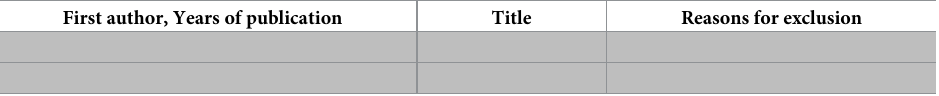
Table 3. Exclusion table from systematic review and meta-analysis of randomized controlled trials to evaluate the effects of PFM exercise on pregnant women with GDM and gestational urinary incontinence and/or pelvic floor muscle